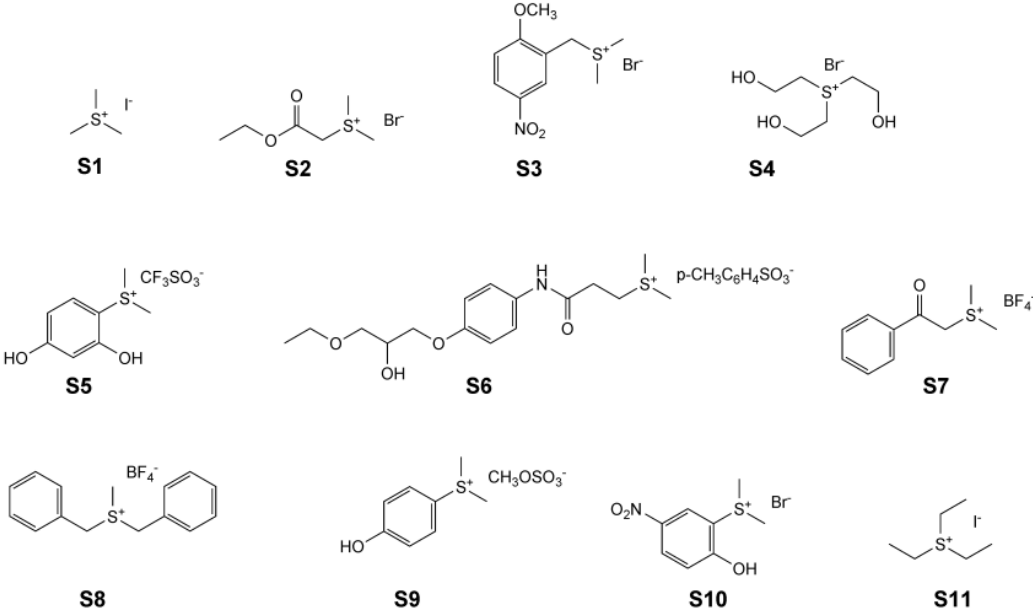
Figure 1. The structures of sulfonium compounds described in this study. Full compound names are defined in Materials and Methods.